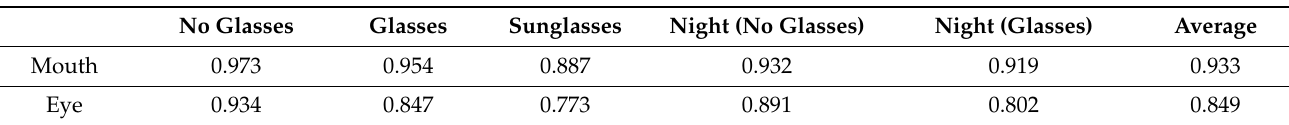
Table 2. The evaluation dataset of the NTHU-DDD dataset was used to verify the average accuracy of the eye and mouth state detection model in different